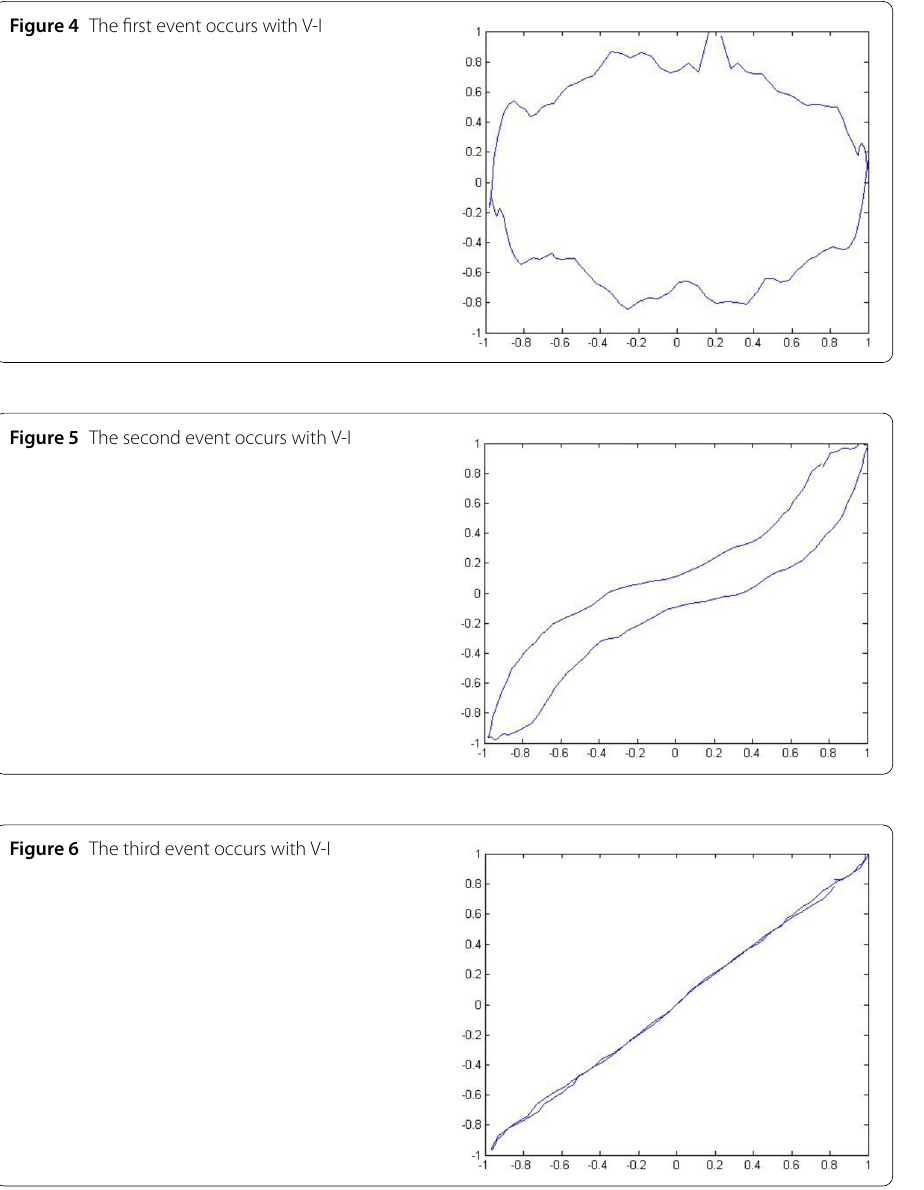
Figure 4 The first event occurs with V-I